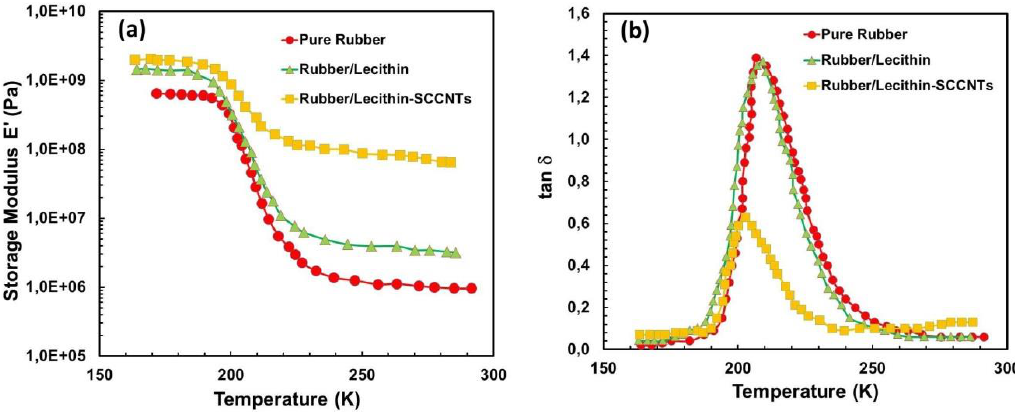
Figure 8. Dynamic-mechanical thermal analysis (DMA) measurements of some select samples. ( a ) Storage modulus as a function of temperature for pure rubber, rubber/lecithin blend (1:1) and 20 wt % SCCNT-loaded bio-nanocomposite (no cellulose impregnation) and ( b ) loss factor (tan δ ) of the same materials as a function of temperature.